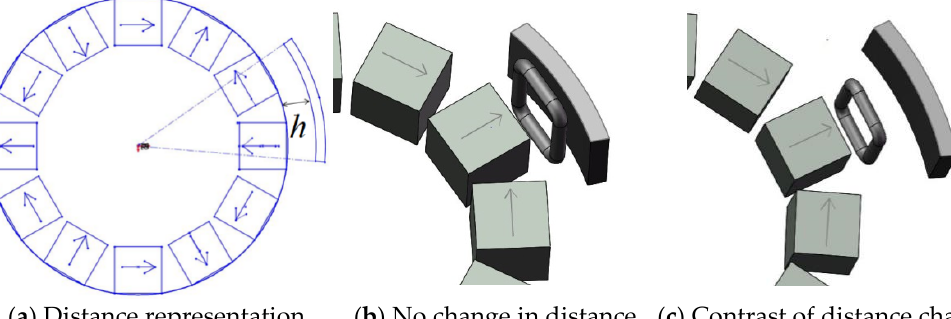
Figure 9. The distance between iron sheet and the Halbach array.